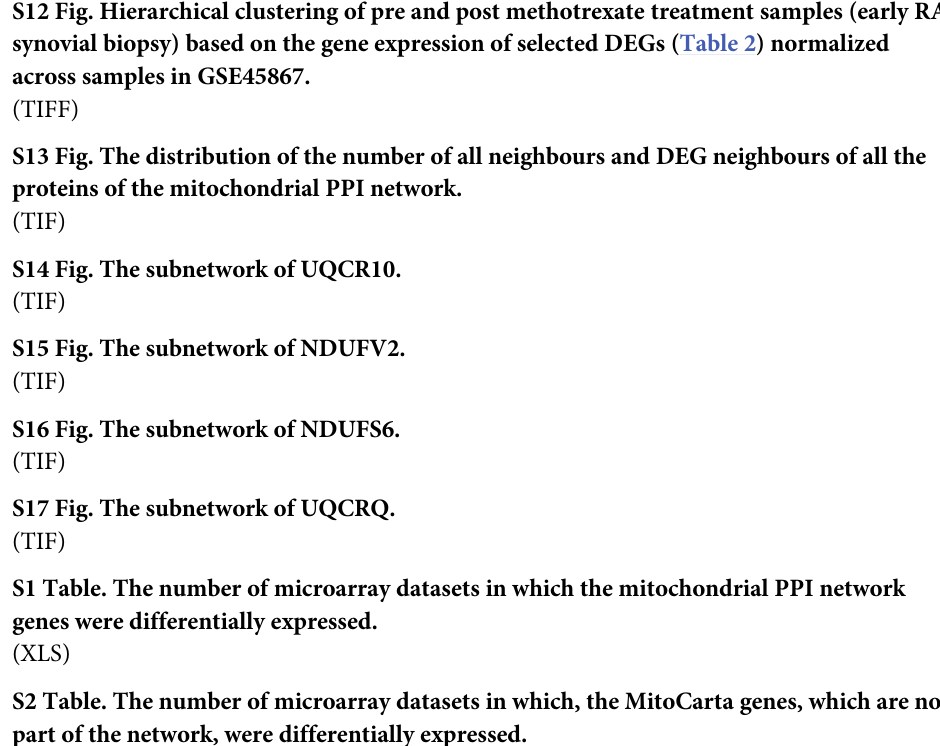
S9 Fig. Hierarchical clustering of RA and control samples based on the gene expression of selected DEGs (Table 2) in GSE12021 (HGU133B) after removing RA samples clustered with control samples. (TIF) S10 Fig. Hierarchical clustering of prednisone treated and control samples (whole blood) based on the gene expression of selected DEGs (Table 2) normalized across samples in GSE77344. (TIFF) S11 Fig. Hierarchical clustering of celecoxib treated and control samples (colorectal pri- mary adenocarcinomas)based on the gene expression of selected DEGs (Table 2) normal- ized across samples in GSE11237. S12 Fig. Hierarchical clustering of pre and post methotrexate treatment samples (early RA synovial biopsy) based on the gene expression of selected DEGs (Table 2) normalized across samples in GSE45867. (TIFF) S13 Fig. The distribution of the number of all neighbours and DEG neighbours of all the proteins of the mitochondrial PPI network. S14 Fig. The subnetwork of UQCR10. S15 Fig. The subnetwork of NDUFV2. S16 Fig. The subnetwork of NDUFS6. S17 Fig. The subnetwork of UQCRQ. S1 Table. The number of microarray datasets in which the mitochondrial PPI network genes were differentially expressed. S2 Table. The number of microarray datasets in which, the MitoCarta genes, which are not part of the network, were differentially expressed. (XLSX) S3 Table. Number of neighbours for all mitochondrial PPI network proteins. The table shows the number of first neighbours, the number of DEGs and number of up/down regulated DEGs among the first neighbours. (XLSX) S4 Table. The significantly enriched biological processes (BP) of the RA synovial mito- chondrial